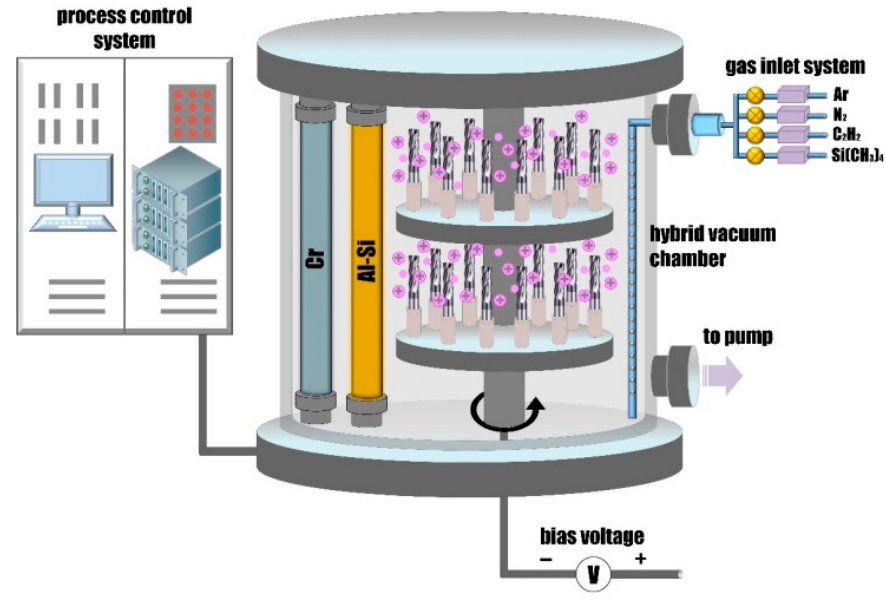
Figure 4. The principal application of DLC-coatings and (CrAlSi)N / DLC-coatings on end mills with the use of hybrid technology unit.